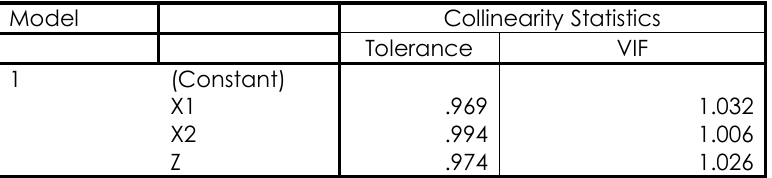
Tabel 8 : Uji Multikolinearitas